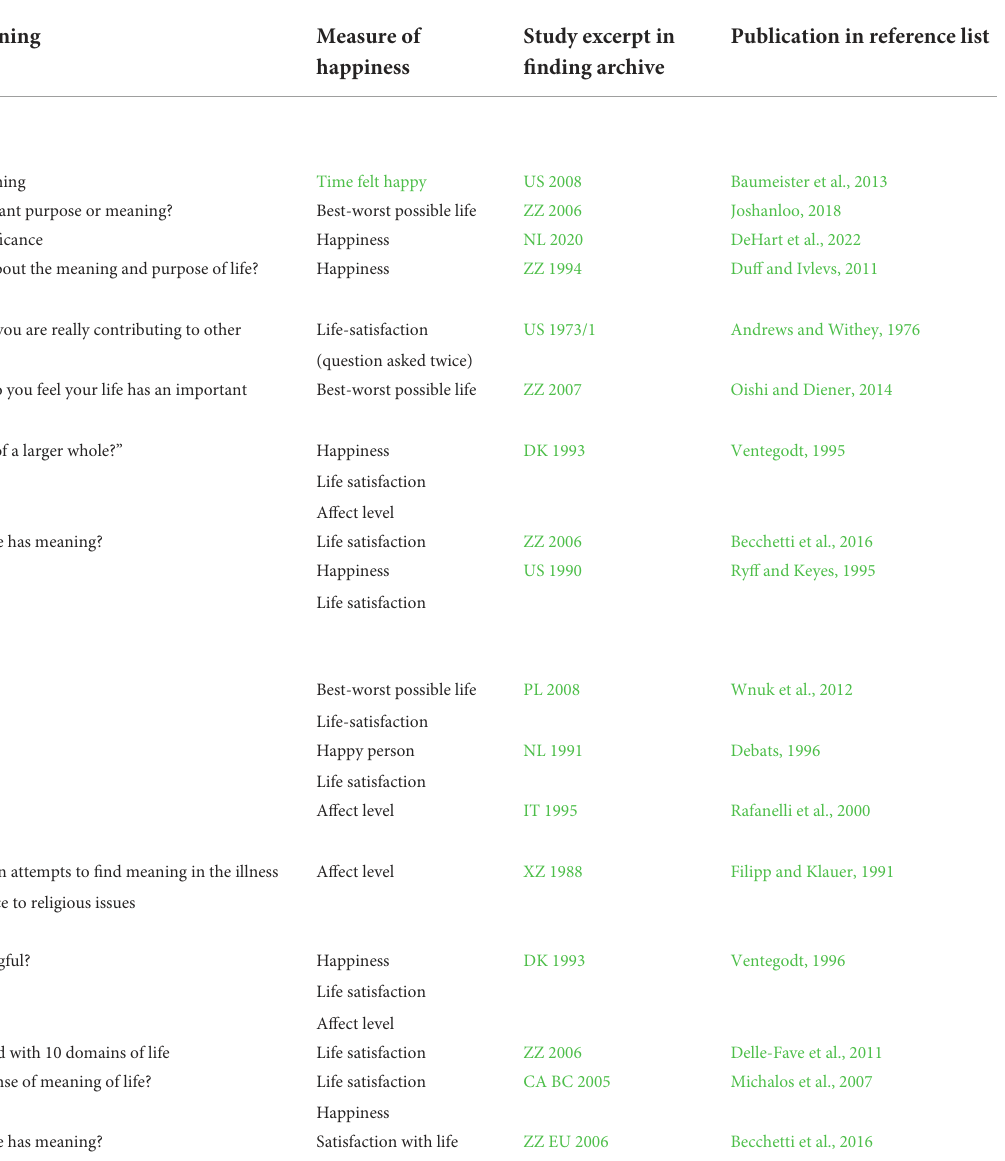
TABLE 1 75 studies in which a correlation between perceived meaning and life satisfaction was